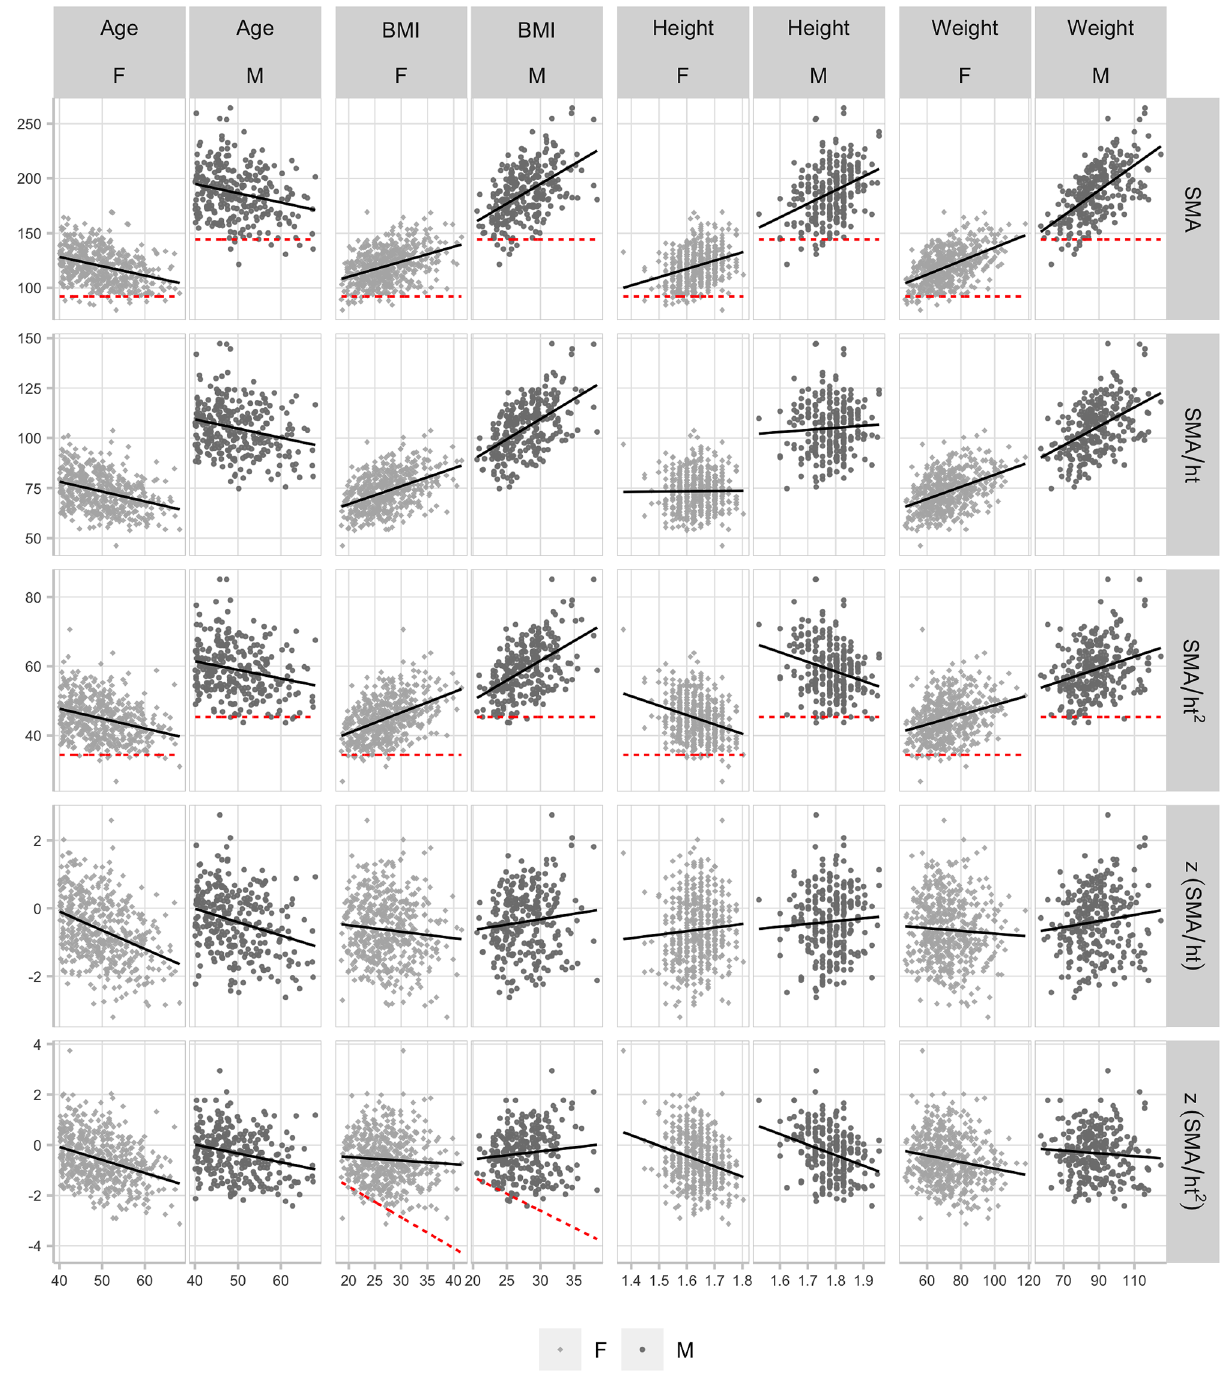
Figure 2. Over-40 cohort: Scatter plots of L3 skeletal muscle area measures versus age, BMI, height, and weight, split by sex. Best-fit linear regression line overlaid (black, solid), and Derstine, 2018 15 sarcopenia ‘fixed’ cutoff values (red, dashed) shown for SMA, SMA HT 2 , and z ( SMA HT 2 ) vs.